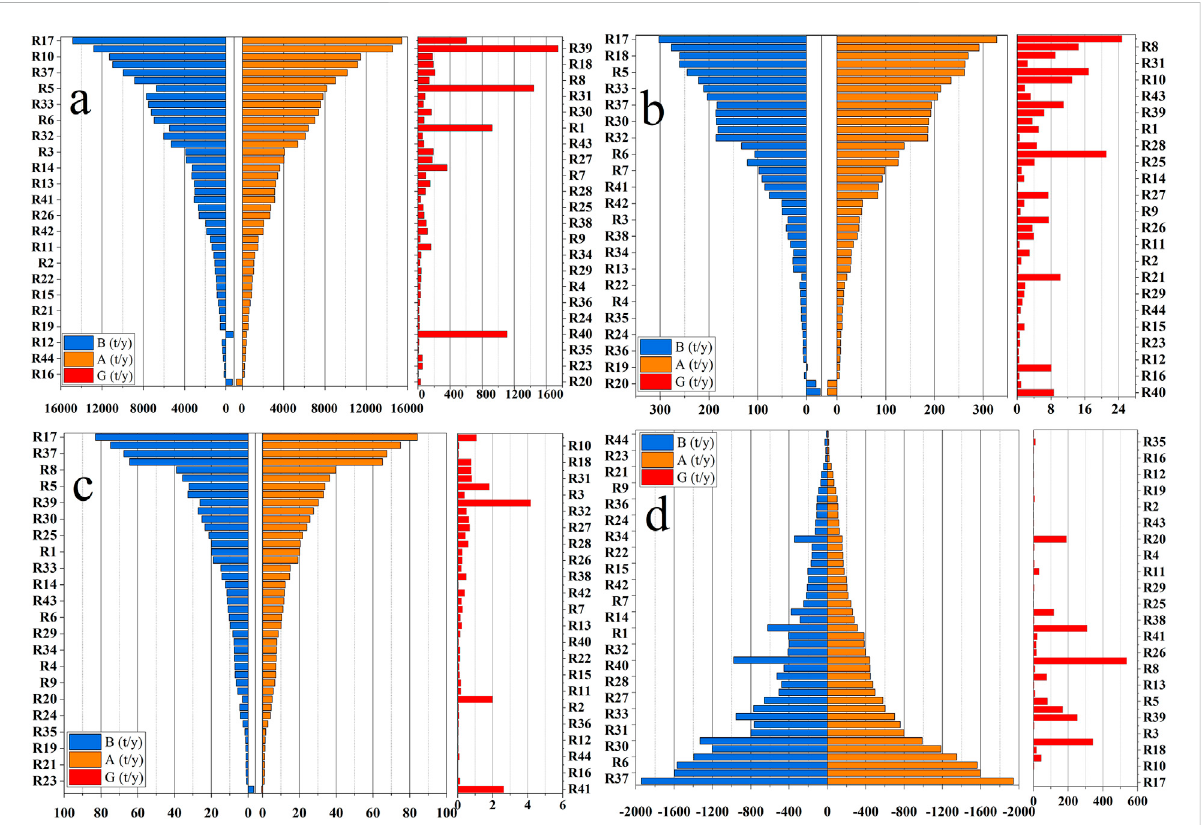
FIGURE 8 Water environmental capacity of COD (A) , NH 3 – N (B) , TP (C) , and TN (D) in the canal network of the study area. B = WEC before industry adjustment,A=WECafterindustryadjustment,andG=WECgrowthvalue.Theordinateofthis fi gureisthecanalinthestudyarea,andthehorizontal axis represents the total amount of pollutants the canal can